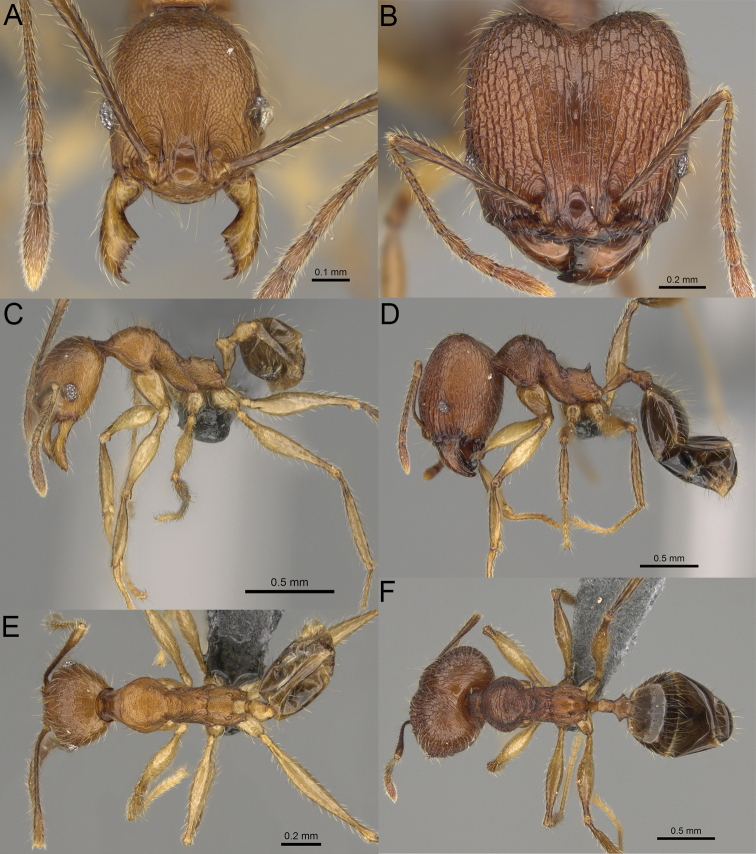
Pheidole
tsaravoniana sp. nov., full-face view (A), profile (C), and dorsal view (E) of paratype minor worker (CASENT0923286) and full-face view (B), profile (D), and dorsal view (F) of holotype major worker (CASENT0300007).